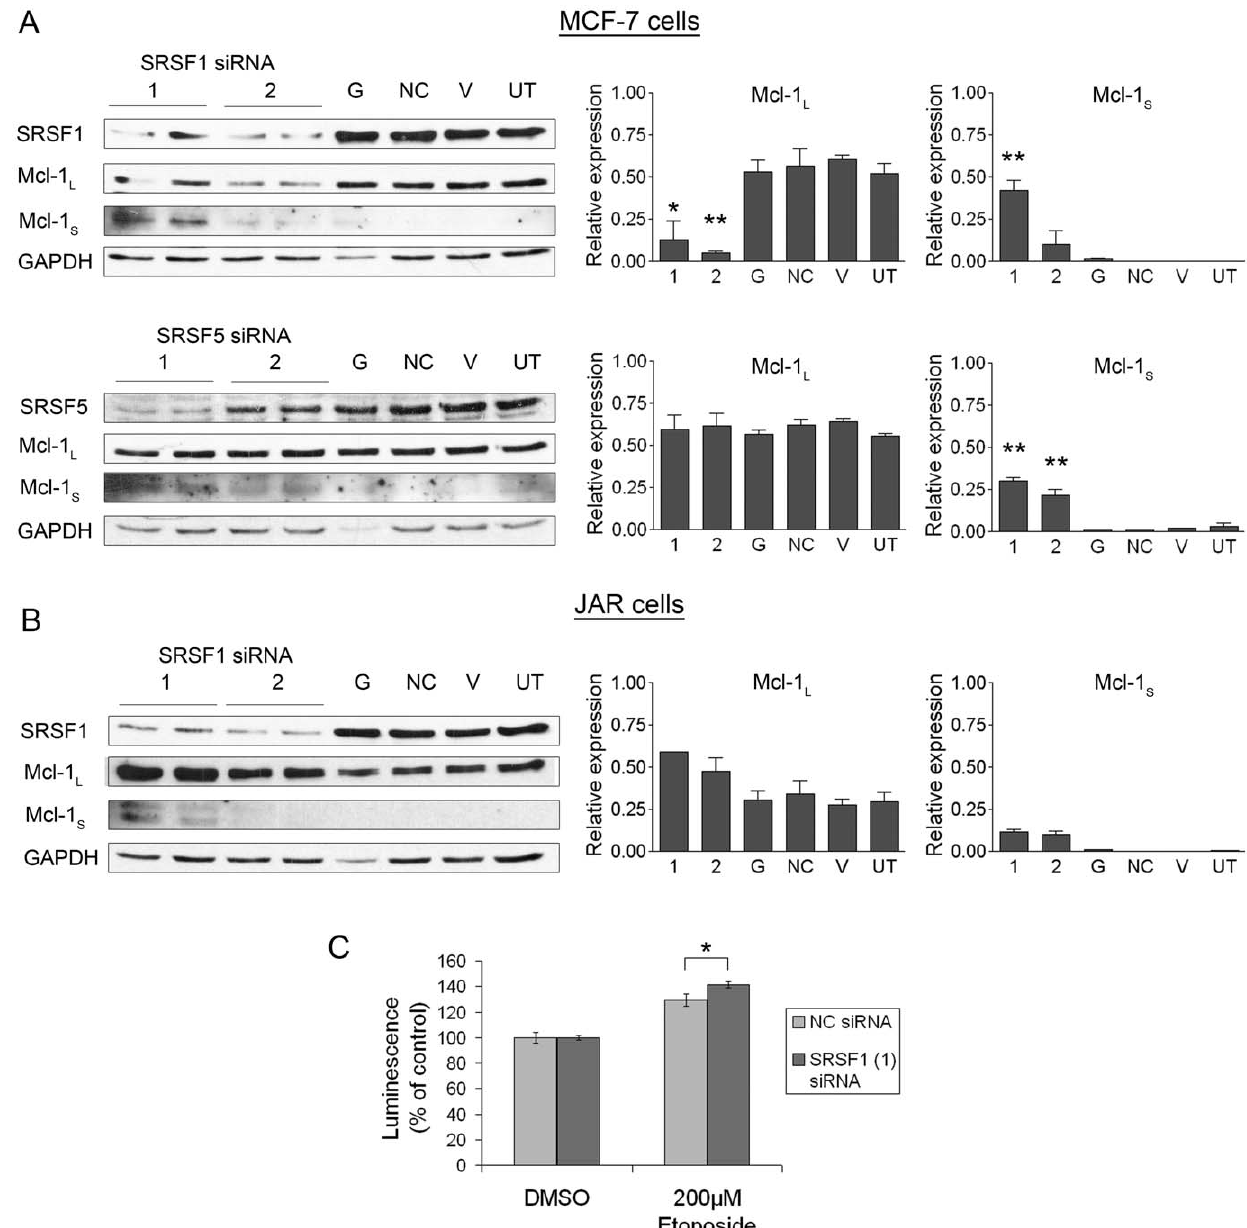
Figure 5. Knockdown of RNA binding proteins and their effect on the protein levels of Mcl-1 splice isoforms. ( A ) MCF-7 cells were transfected with SRSF1 (1 and 2), SRSF5 (1 and 2), GAPDH (G) and Negative control (NC) siRNAs, or treated with vehicle (lipid) only (V), or were untreated (UT). SRSF1, 5, Mcl-1 and GAPDH protein levels were determined by immunoblotting 72 hours after transfection with the siRNAs, using 30 m g of total cell lysate. Histograms show densitometric analysis of Mcl-1 L and Mcl-1 S protein expression. Data are shown as the mean 6 SEM. ** indicates P # 0.01; * indicates P , 0.05. ( B ) JAR cells were transfected with SRSF1 (1 and 2), GAPDH (G) and Negative control (NC) siRNAs, or treated with vehicle (lipid) only (V), or were untreated (UT). SRSF1, Mcl-1 and GAPDH protein levels were determined by immunoblotting 72 hours after transfection with the siRNAs, using 30 m g of total cell lysate. ( C ) After transfection with SRSF1 (1) and NC siRNA MCF-7 cells were treated with 200 m M etoposide or DMSO control for 6 hours. Induction of apoptosis was assessed by measuring caspase3/7 activity.* indicates P , 0.05.